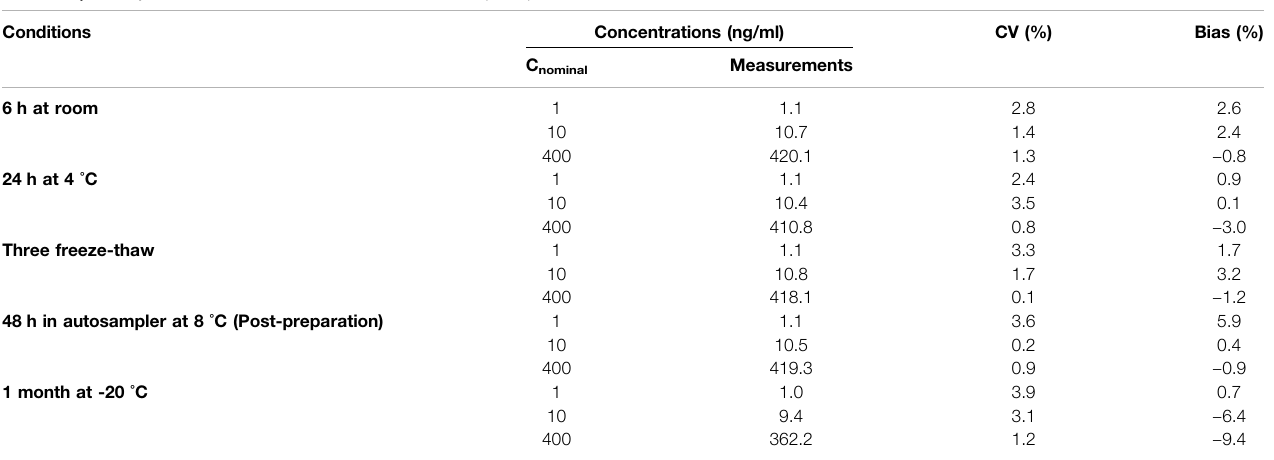
TABLE 3 | Stability evaluation of TFV under different conditions ( n (cid:2) 6).